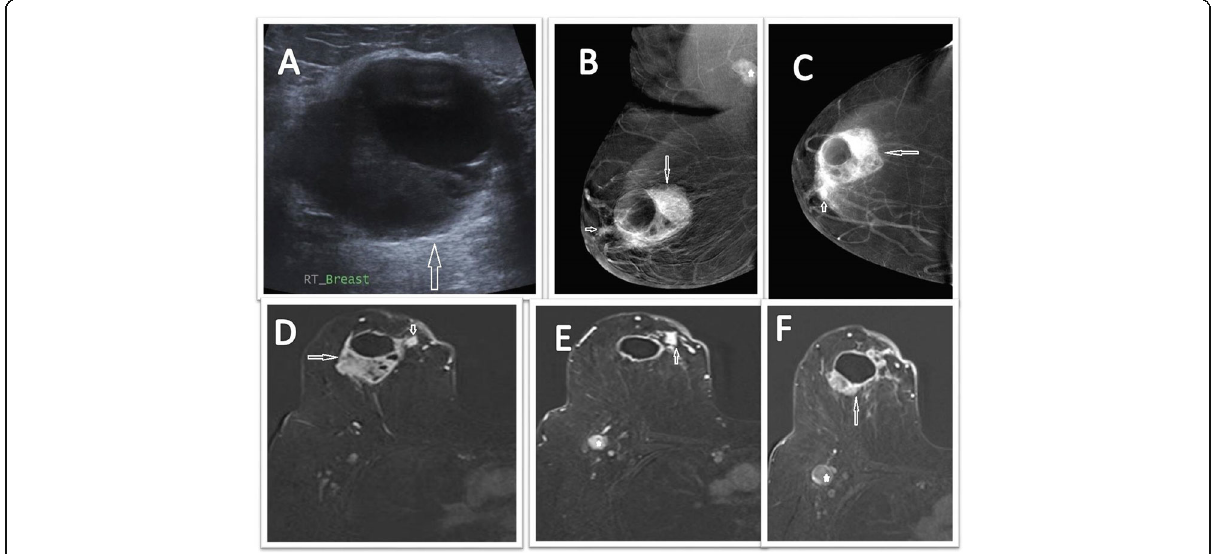
Fig. 2 Female patient 48 years old. She came with routine check-up mammography. There was an irregular speculated lesion with central lucency seen on mammography (arrows in a , b ). An ultrasound ( e ), the lesion appears as an irregular, ill-defined hypoechoic lesion with posterior shadowing at 12 o ’ clock (arrow). On CESM ( c , d ), it shows moderate enhancement (arrows). On MRI with IV contrast ( f , g ), it appears as an irregular speculated enhancing lesion with dynamic curve type I (arrows). A biopsy was done and histopathologically proven